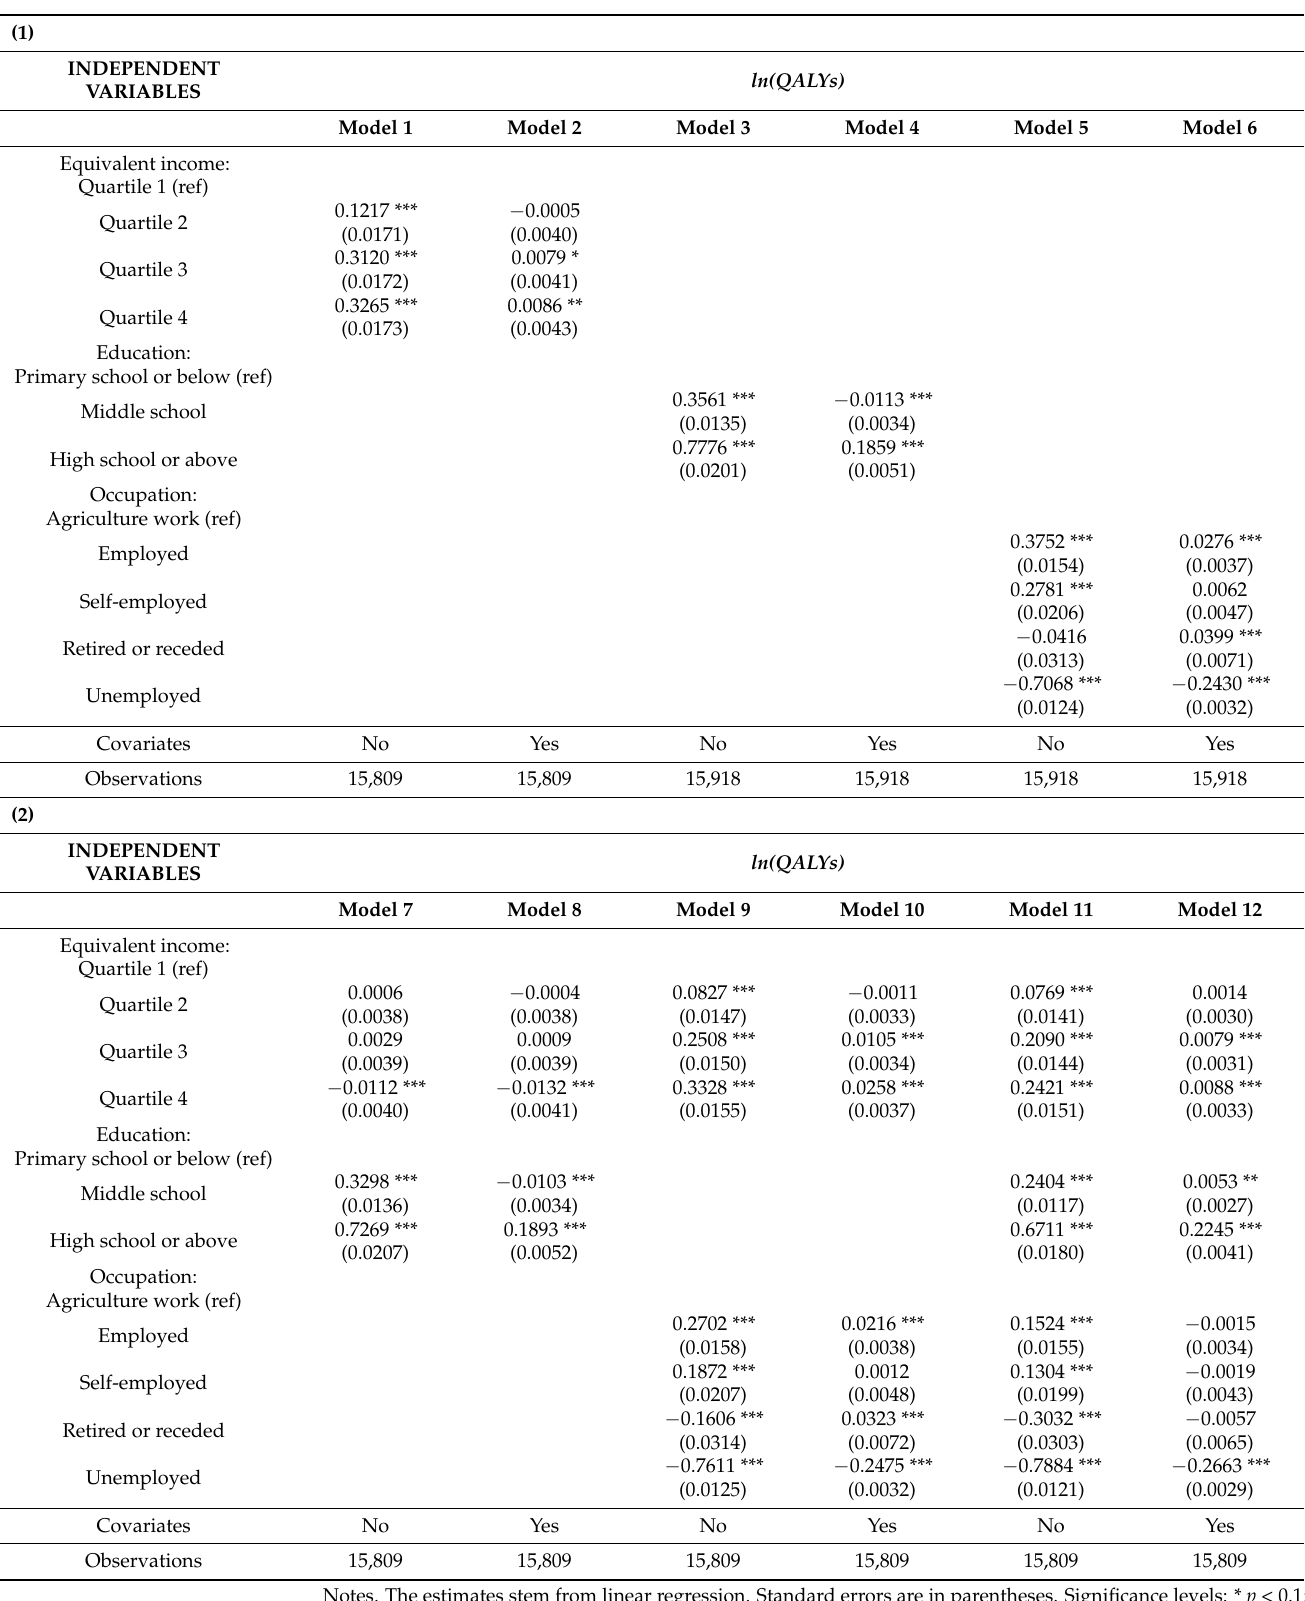
Table 2. The impact of socioeconomic status on